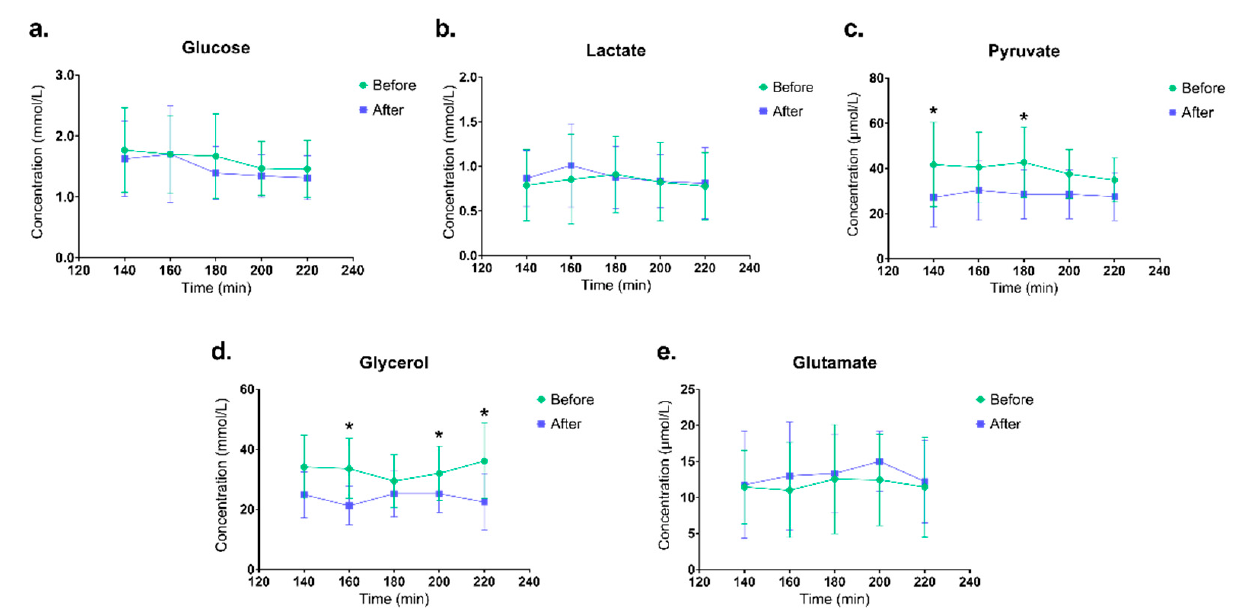
Figure 6. An overview of the metabolite concentrations over time ( a ) Glucose concentrations; ( b ) Lactate concentrations; ( c ) Pyruvate concentrations; ( d ) Glycerol concentrations; ( e ) Glutamate concentrations. The concentrations of the metabolites at baseline (140 min), working period (160–180 min) and recovery period (200–220 min) are shown as mean value and the bars represent standard deviation. * indicates a statistical significant ( p < 0.05) differences between samples before dynamic computer working (DCW) and after 4 -weeks DCW.